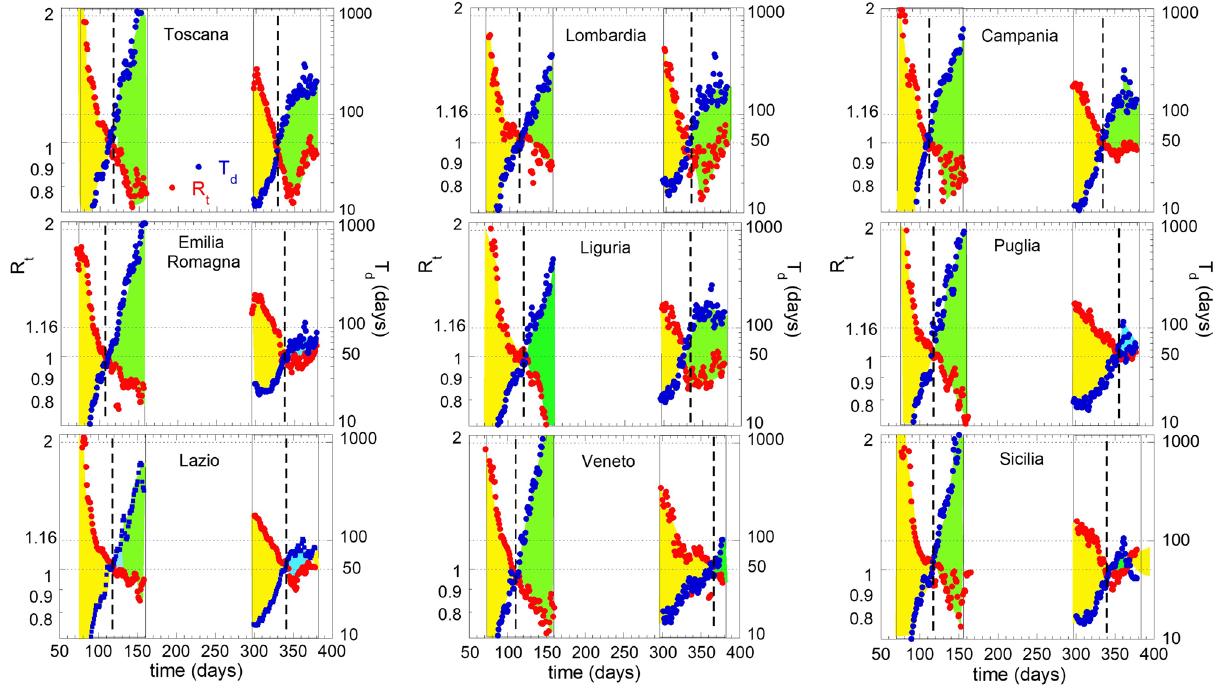
Figure 3. T d and R t vs. time in nine selected Italian regions. In the supercritical regime [yellow areas] the doubling time (red) increases in the range 2 < T d < 40 days while the reproductive number R t decreases to 1. We omitted data of the arrested phases, where T d and R t fluctuate around maximum and minimum values, respectively. The green area identifies the metastable phases from where the epidemic spreading may evolve towards an arrested phase or a new epidemic